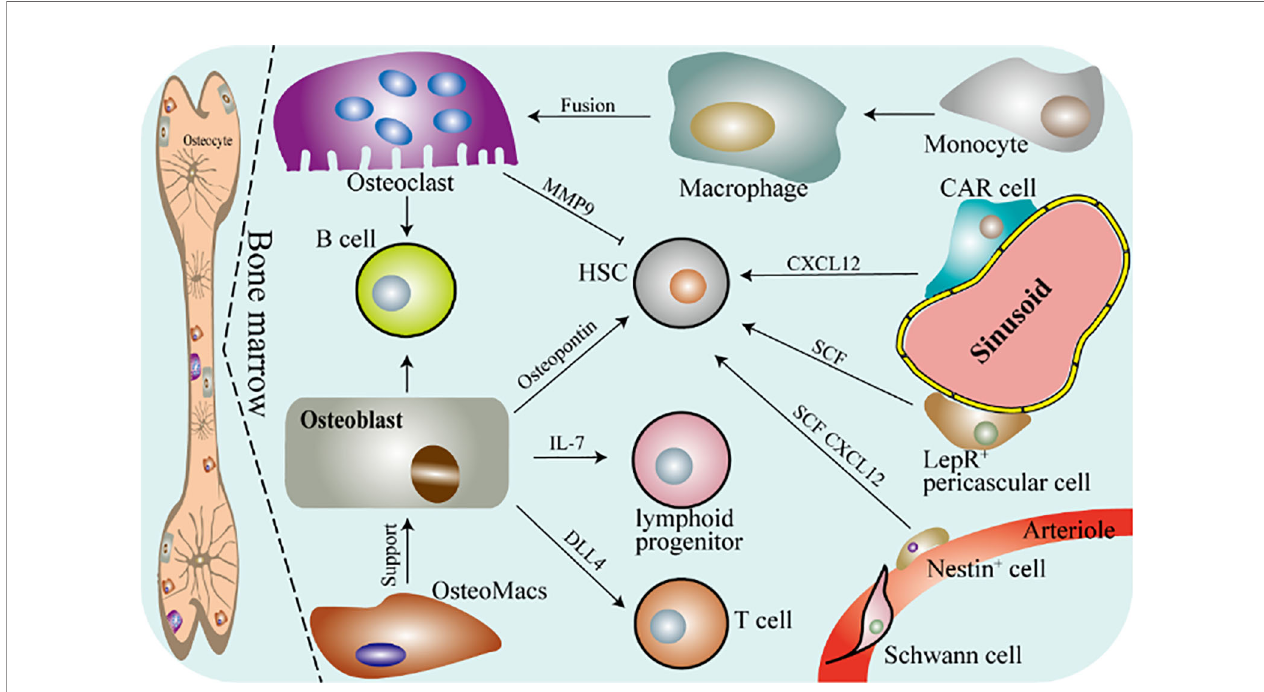
FIGURE 1 | Schematic diagram of osteoimmunity. DLL4, delta-like protein 4; CAR, CXC chemokine ligand (CXCL) 12-abundant reticular; SCF, stem cell factor; HSC, hematopoietic stem cell; LepR, leptin receptor-expressing. Bone marrow mainly contains osteocytes, osteoblasts, osteoclasts, OsteoMacs and macrophages. OsteoMacs refers to the macrophages residing in the bone marrow, accounting for 15% to 20% of the total bone marrow cells. And they are mainly located near osteoblasts and support the generation of osteoblasts and bone formation. Macrophages are differentiated from monocytes derived from peripheral blood and further form osteoclasts. Bone is the cradle of immune cells, osteoclasts and osteoblasts are involved in regulating the immune response of a variety of immune cells. And they can also regulate the function of hematopoietic stem